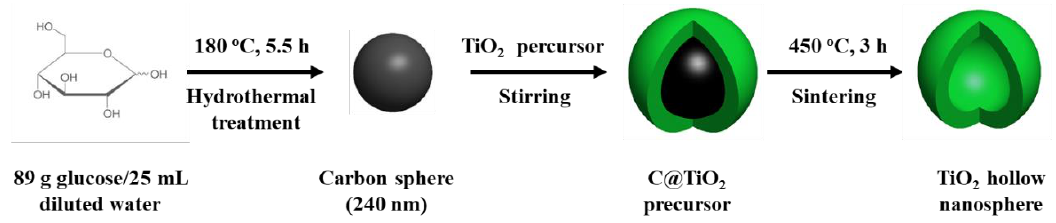
Figure 1. Schematic illustration of the synthesis procedure of spherical carbon nanoparticles (NPs).